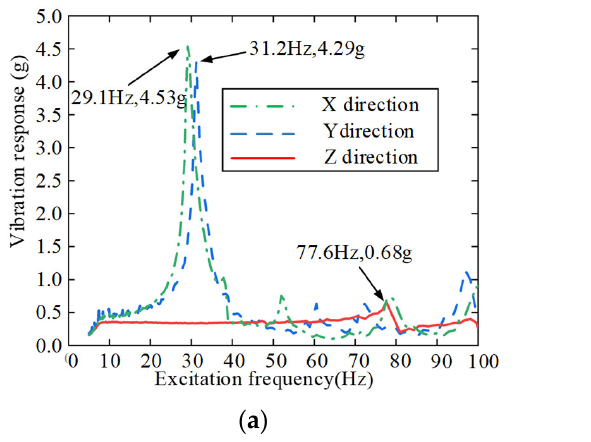
Figure 16. Vibration test.